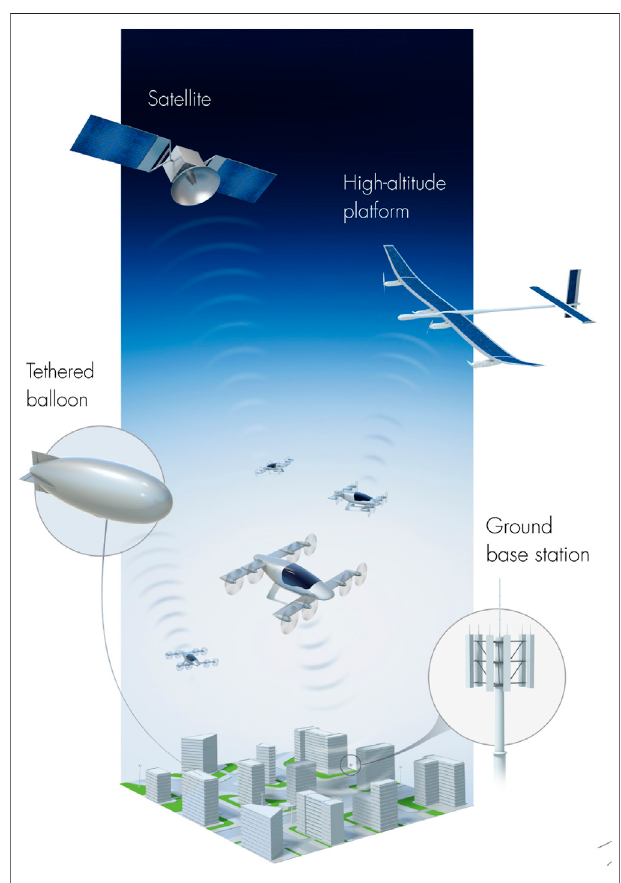
FIGURE 2 | Potential eVTOL connectivity